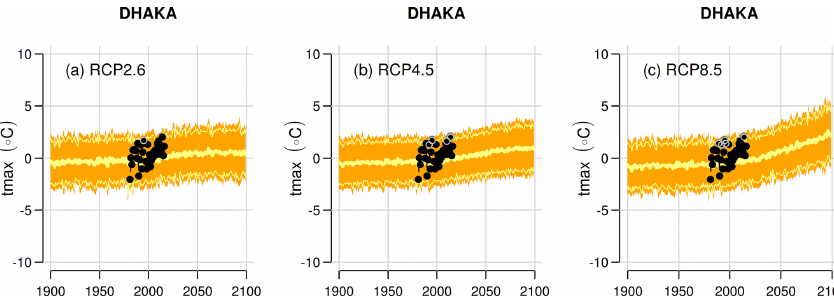
Figure 7. Downscaled projections of the maximum temperature in the pre-monsoon season (March–May) in Dhaka for emission scenarios RCP2.6, RCP4.5, and RCP8.5. The figures show the change relative to the period 1981–2010. The shaded area indicates one standard deviation from the mean based on the included GCM simulations for each experiment.